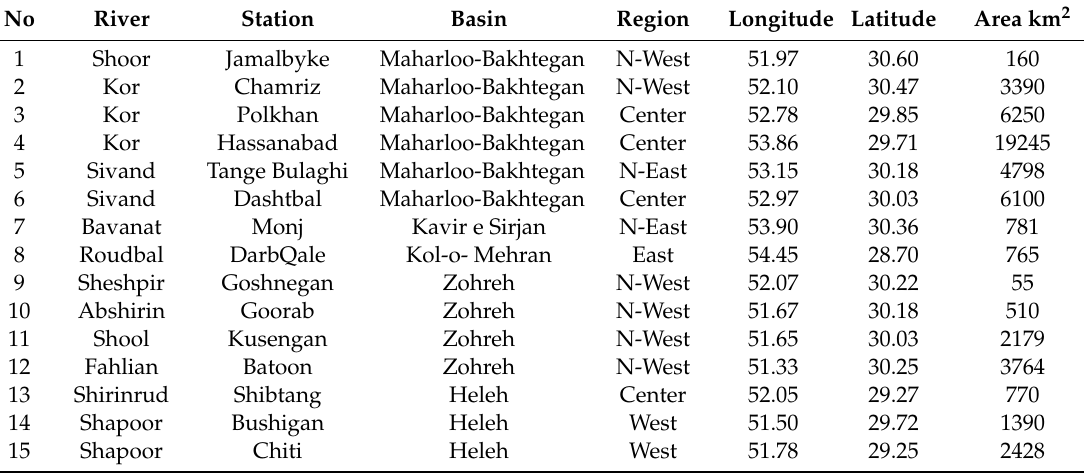
Table A2. Information on gauging stations that supplied flow